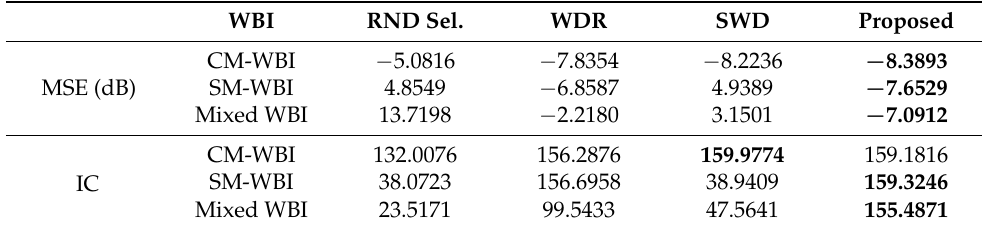
Table 3. MSEs and ICs of the imaging results obtained via random selection (RND Sel.), WBI detection and removal (WDR), simple waveform design (SWD), and the proposed method. WBI RND Sel.